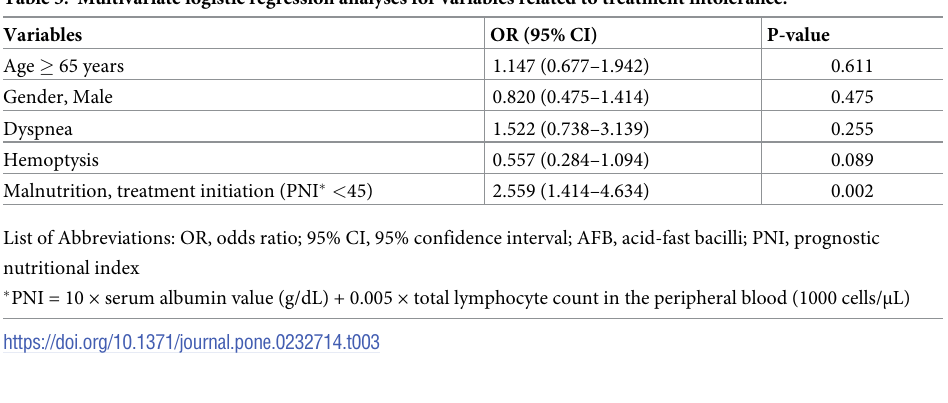
Table 3. Multivariate logistic regression analyses for variables related to treatment